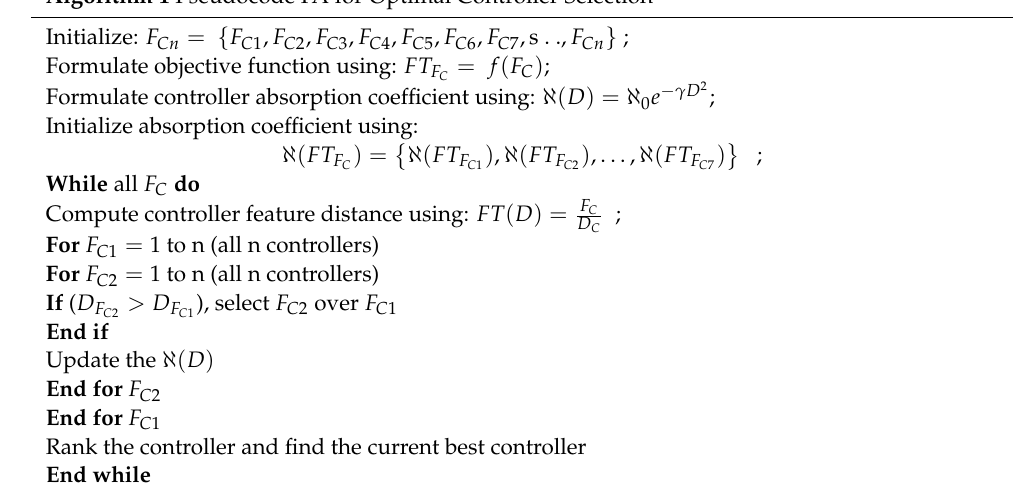
Algorithm 1 Pseudocode FA for Optimal Controller